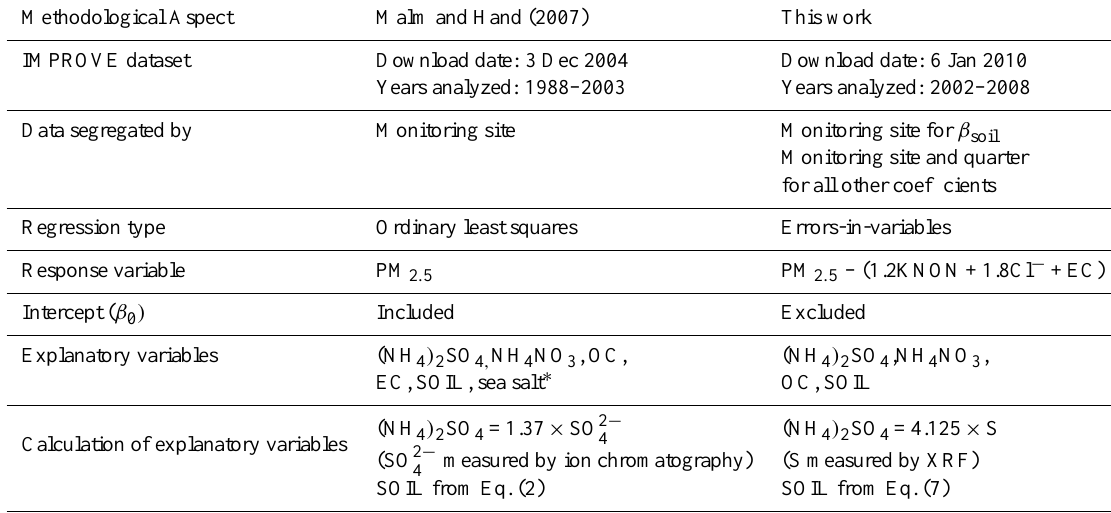
Table 3. Differences between our regression methodology and that of Malm and Hand (2007).